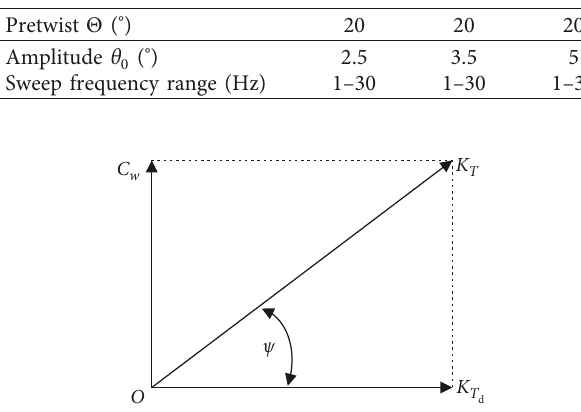
Figure 10: Dynamic characteristic parameter diagram.